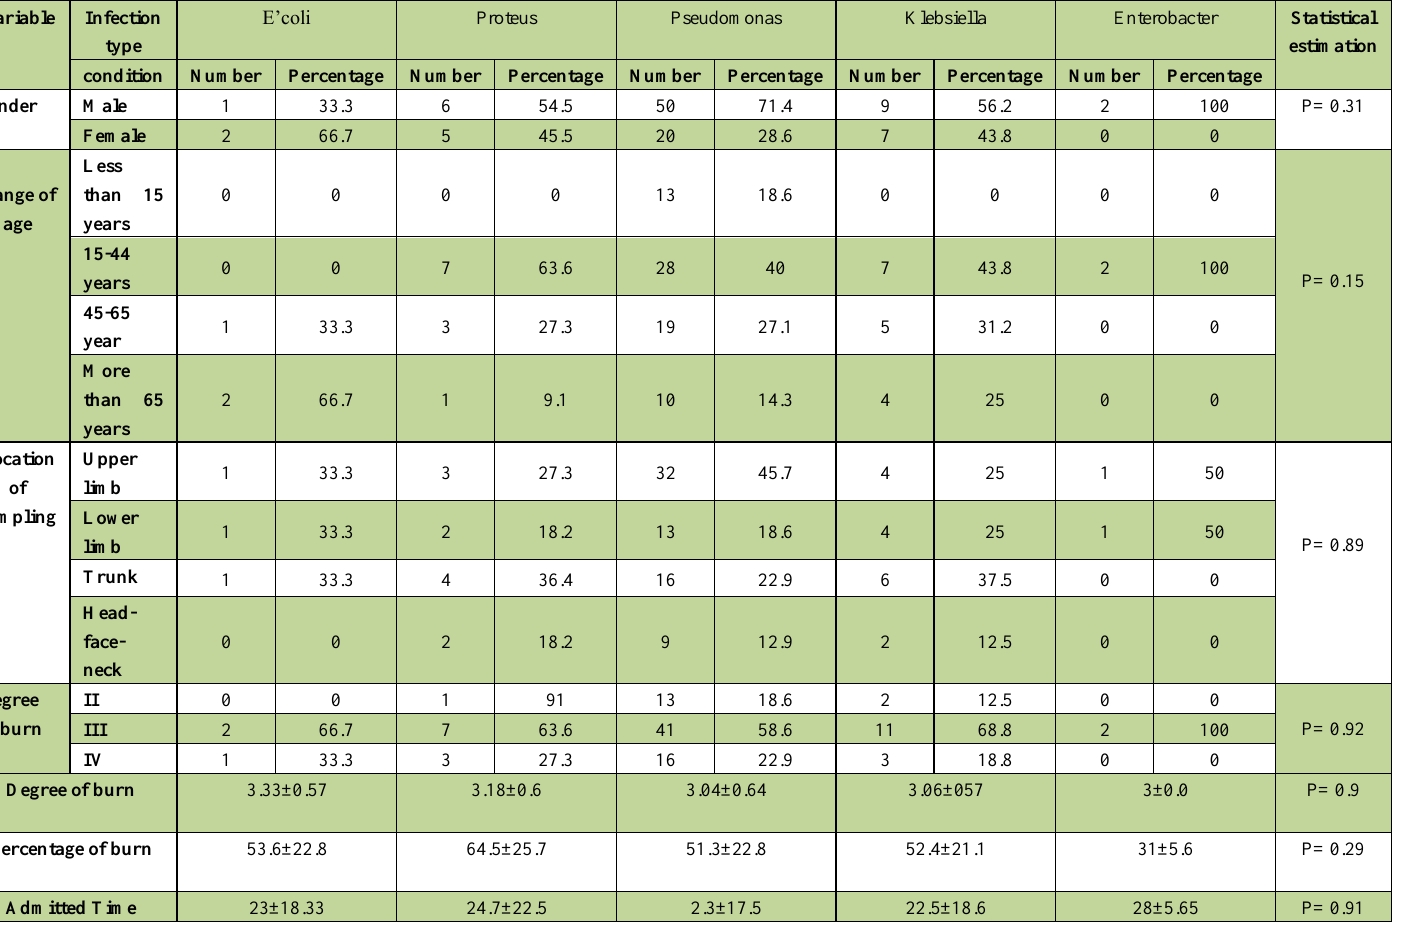
Table8. Frequency Distribution of Different Types of Bacterial Factors Identified in Burn Wound Cultures in Patients Admitted to ICU by Gender- Age - Sampling Area - Degrees of Burn